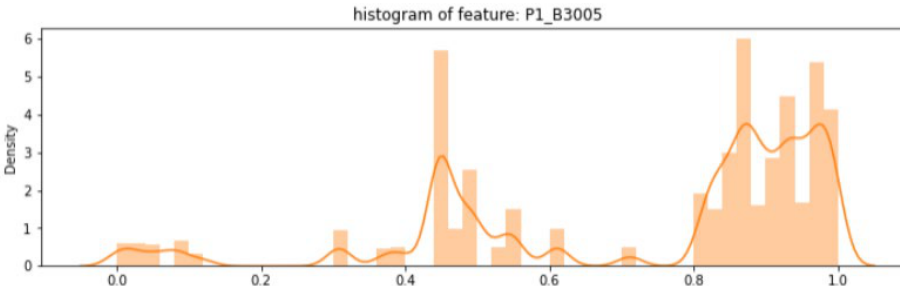
Figure 7. Feature graph for data point P1_B3005.